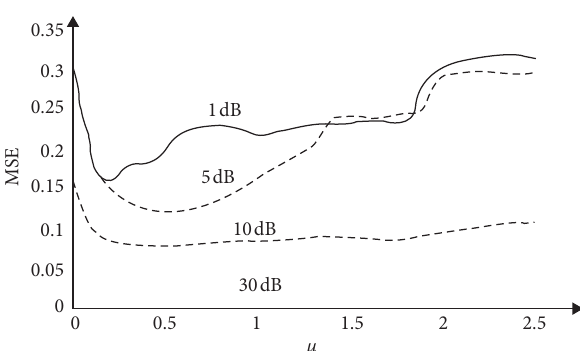
Figure 6: Parameters μ restoration effect under the influence of the signal-to-noise